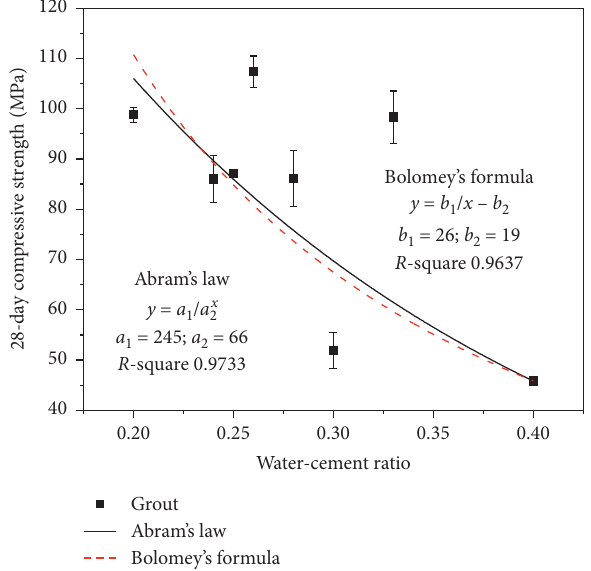
Figure 1: Simulations of Abrams’ law and Bolomey’s formula for grout.